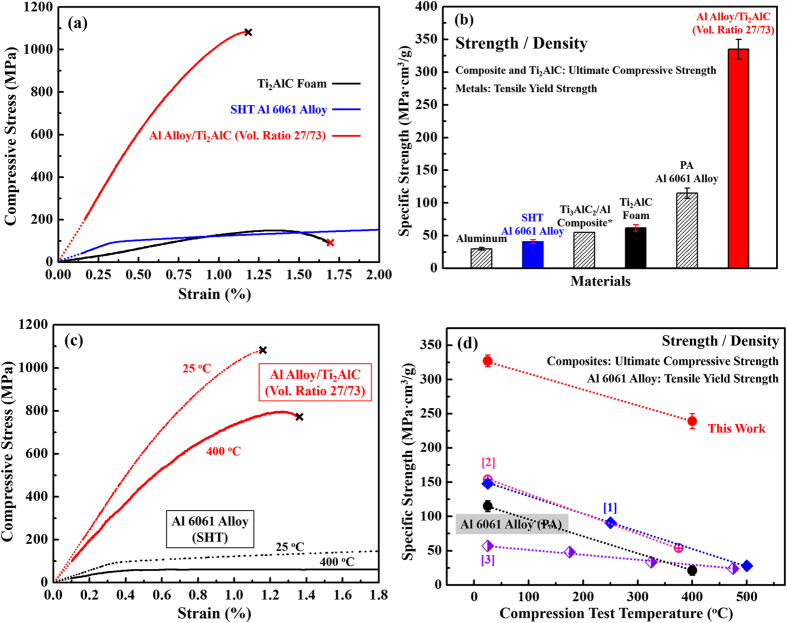
(a) Typical stress-strain curves of the Al alloy/Ti2AlC (volume ratio 27/73) composites, solution heat treated (SHT) Al 6061 alloy, and Ti2AlC foams. (b) Specific strength of the Al alloy/Ti2AlC (volume ratio 27/73) composites, peak aged (PA) Al 6061 alloy, and Ti2AlC foams, previously reported Ti3AlC2/Al composites7, SHT Al 6061 alloy, and pure Al. (c) Typical stress-strain curves of the Al alloy/Ti2AlC (volume ratio 27/73) composites and SHT Al 6061 alloy at 25 °C and 400 °C. (d) Specific strength as a function of test temperature for the Al alloy/Ti2AlC (volume ratio 27/73) composites from the present study (red), previously reported composites (i.e. Ti3AlC2/Al7 (blue [1]), B4C/Al17 (pink [2]), and Al2O3/Al15 (purple [3]), and PA Al 6061 alloy (black).